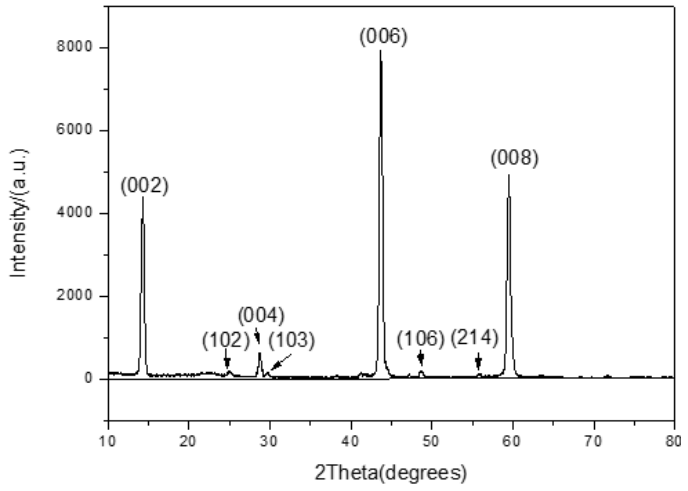
Figure 3. XRD pattern of polyscrystalline HgI 2 film.